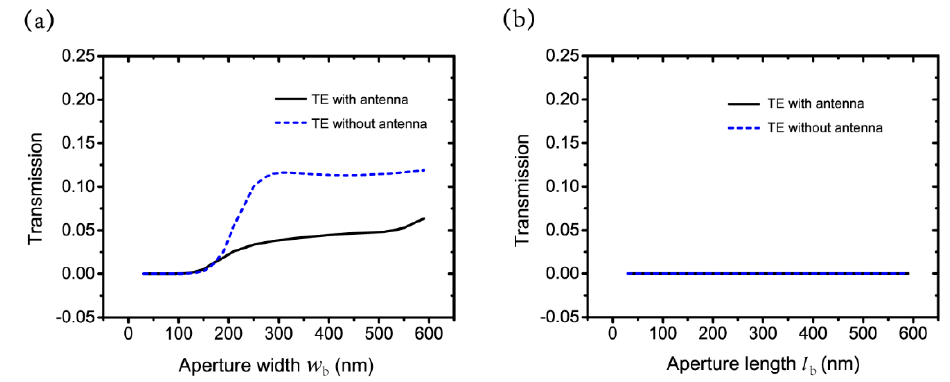
Figure 5. Transmission of di ff erent ( a ) w b and ( b ) l b with and without antenna for TE polarization.